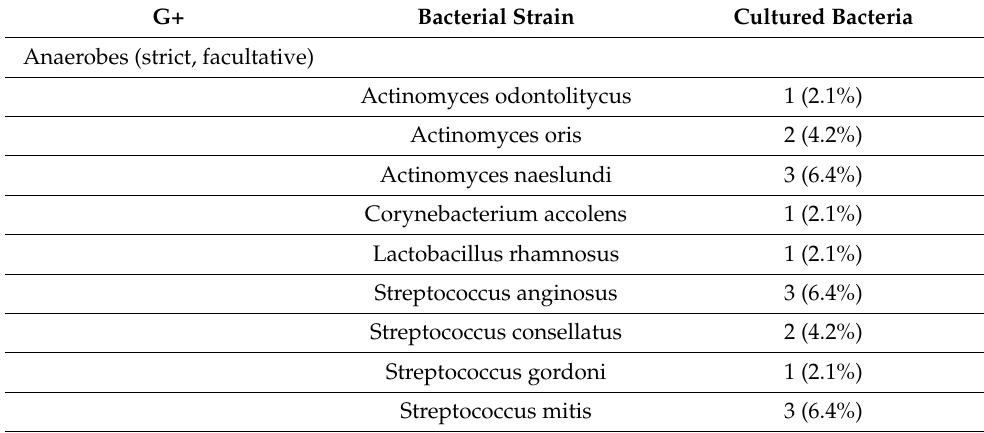
Table 3. Gram-positive bacteria detected in post-extraction tooth socket.